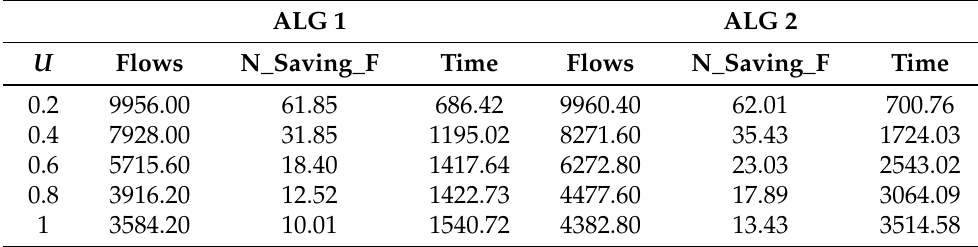
Table 10. 8192 servers-10,000 flows-Flow scheduling with simple heuristics in phase 2.